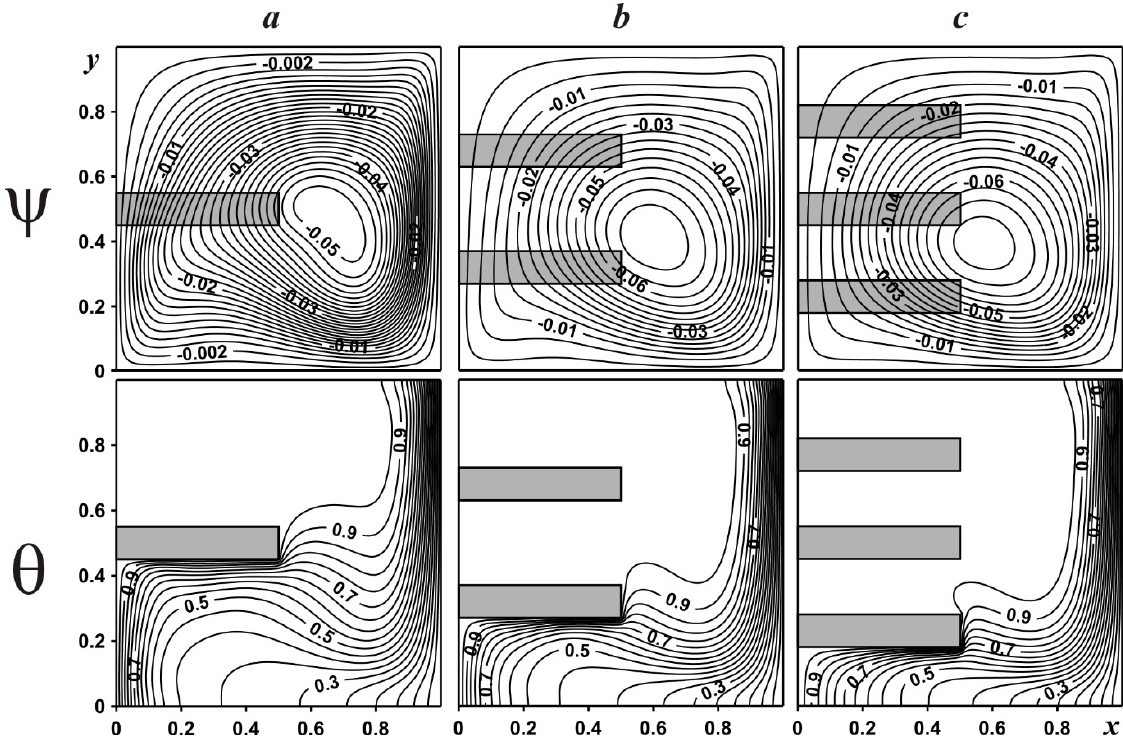
Figure 5. Streamlines and isotherms in a cavity with porous copper fins at Da = 10 − 2 : one fin ( a ); two fins ( b ); three fins ( c ).